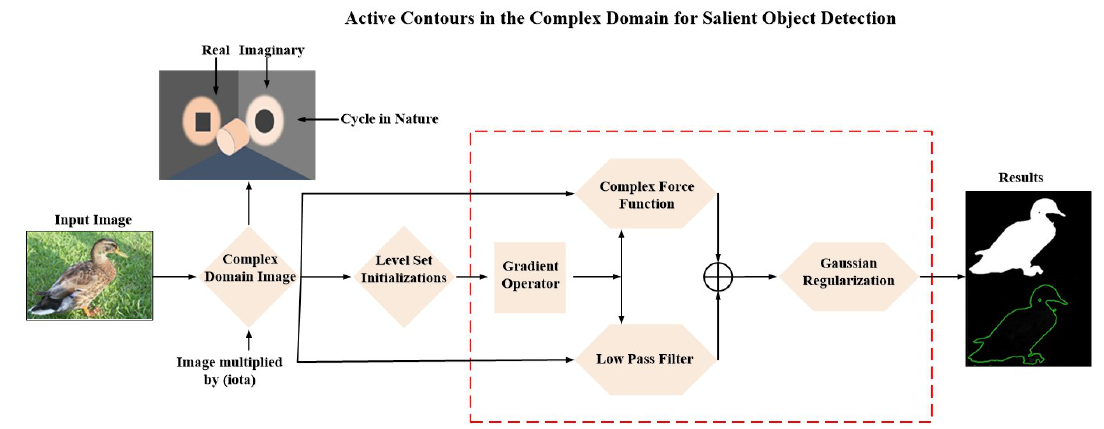
Figure 2. Illustration of the architecture of our ACCD_SOD algorithm.